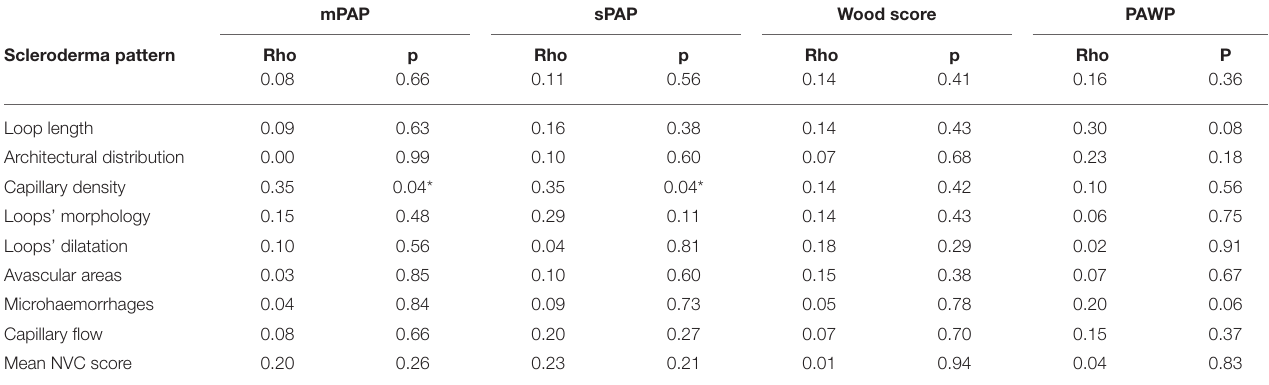
TABLE 3 | Correlation between capillaroscopic parameters and the main haemodynamic/echocardiographic findings regarding 35 SSc patients with pulmonary hypertension. mPAP sPAP Wood score PAWP Scleroderma